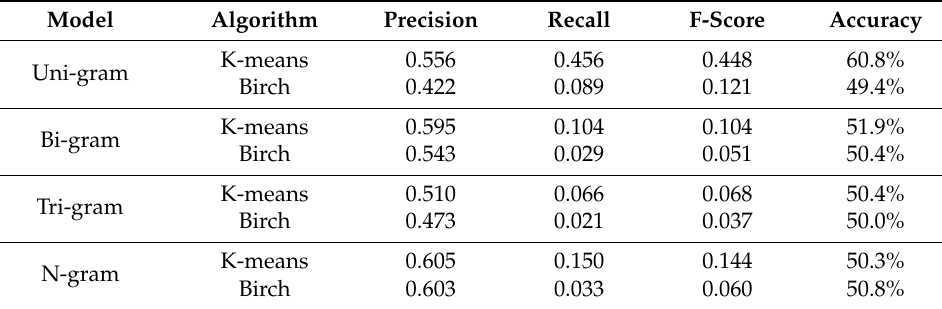
Table 12. Summary for clustering algorithms with n-gram model on test dataset.